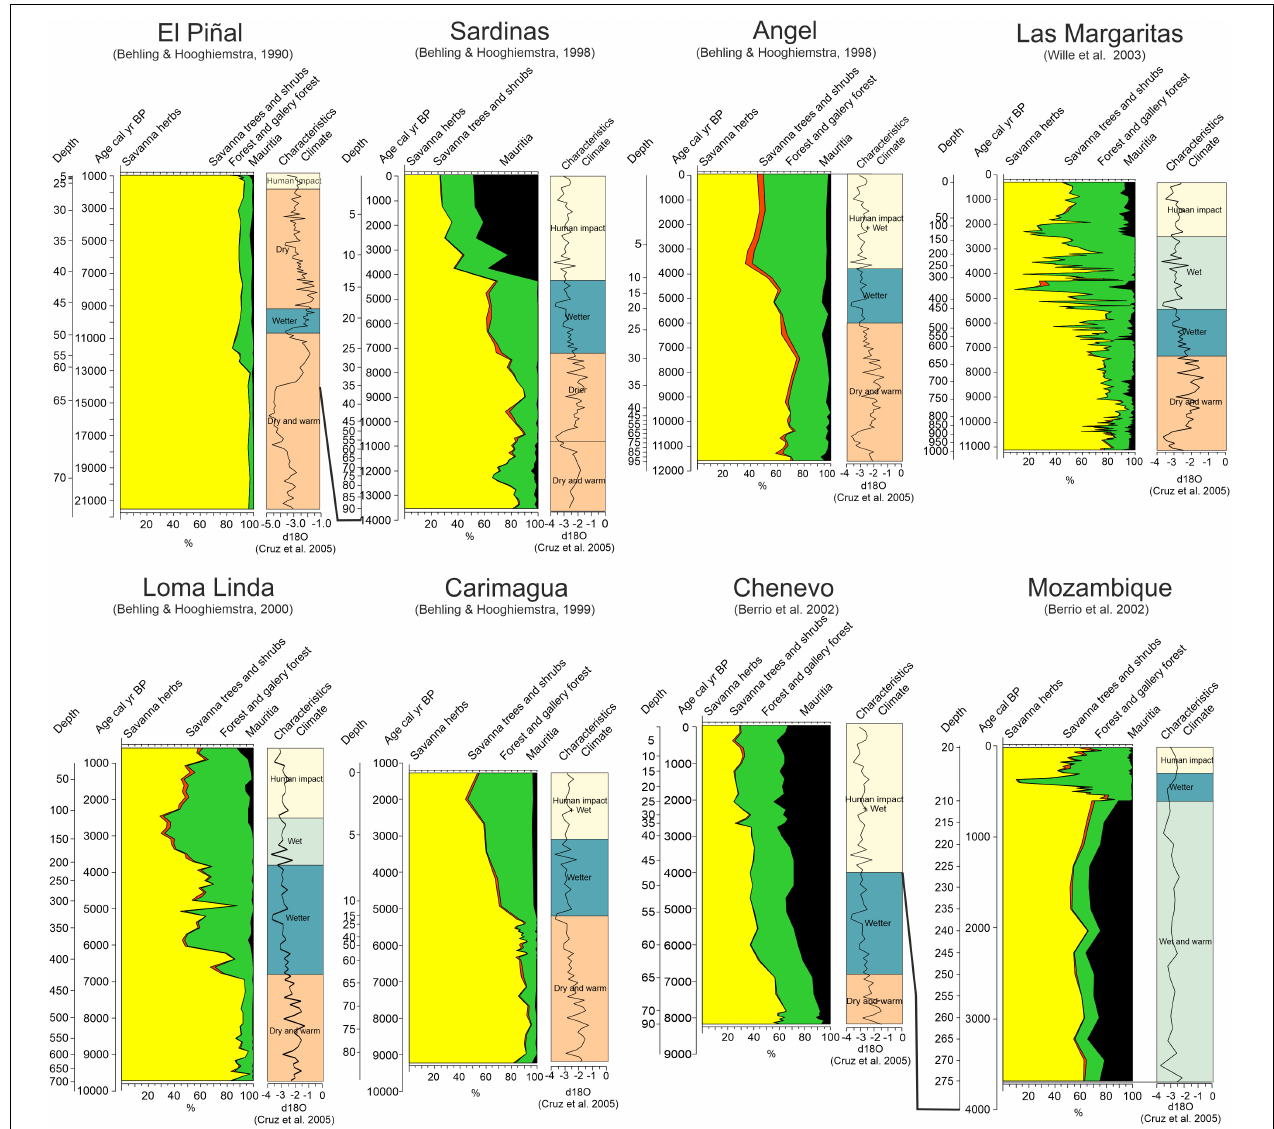
FIGURE 2 | Summary pollen diagrams of the study sites in the Llanos Orientales (available from open source databases); El Piñal (Behling and Hooghiemstra, 1999), Laguna Sardinas and Laguna Angel (Behling and Hooghiemstra, 1998), Las Margaritas (Wille et al., 2003), Loma Linda (Behling and Hooghiemstra, 2000), Carimagua (Behling and Hooghiemstra, 1998), Cheveno and Mozambique (Berrio et al., 2002). Synthetic pollen curves represent different vegetation types: Savanna herbs; main pollen types: Poaceae and Cyperaceae (yellow), savanna trees and shrubs; main pollen types: Byrsonima , Didymopanax and Curatella (orange), Forest and Gallery forest; main pollen types: Arecaceae, Alchornea, Moraceae, Melastomataceae (green), Mauritia swamps (black) main pollen types: Mauritia . Climatic interpretation and characteristics of the identified periods and the climate-based proxy d18O (Cruz et al., 2005) from a stalagmite record in Brazil (Botuverá cave) are plotted; dry and warm (light-orange), wetter (dark blue), wet (light-blue), human impact (pale-orange). Climatic interpretations are based on the original publications. Displayed pollen and d18O data were obtained from Neotoma Paleoecology Database and SISAL, respectively (Atsawawaranunt et al., 2018; Williams et al.,